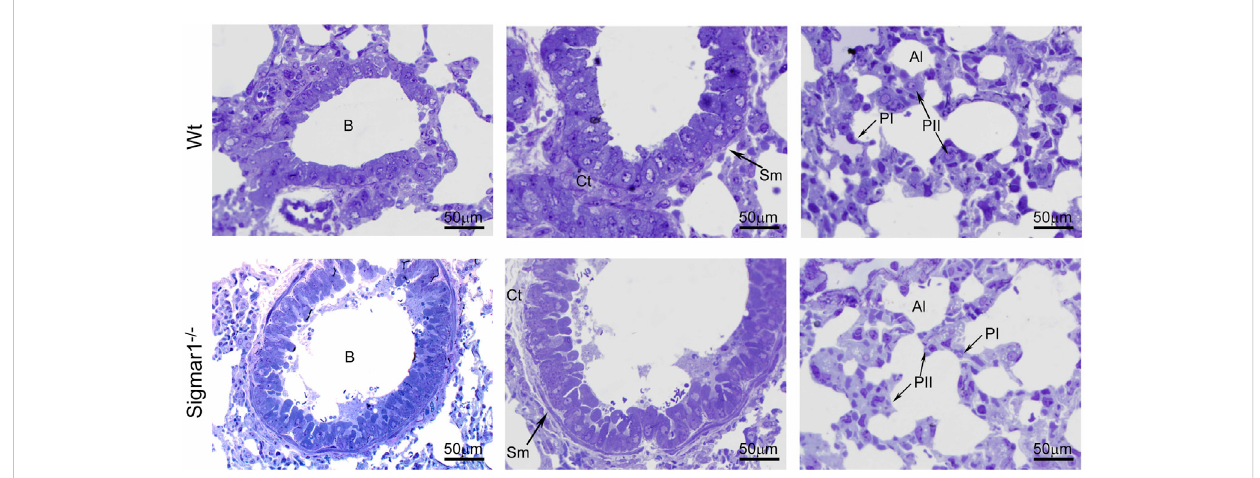
FIGURE 5 ToluidinebluestainingofsemithinsectionsshowingthealteredalveolarstructureinagedSigmar1 − / − mouselung.AssessmentoftheToluidineblue- stained semithin sections showed proper organization of organelles in the aged Sigmar1 − / − and Wt mouse lung (n = 3 per group). B = Lumen of bronchioles, Sm = Smooth muscle cells, Ct = Connective tissue, Al=Alveoli, PI = Pneumocyte type I, PII = Pneumocyte type II. Scale bars: 50